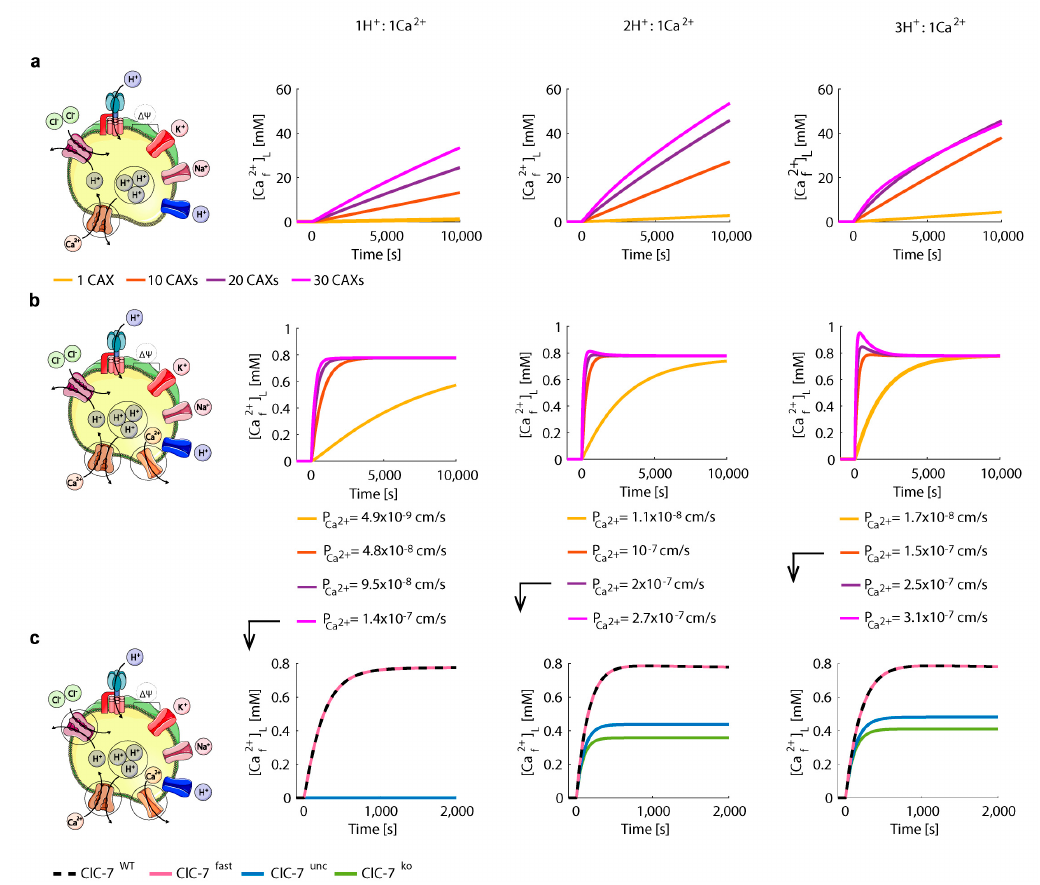
Figure 5. Ca 2+ /H + exchange mediates effective Ca 2+ uptake in the presence of a Ca 2+ leak. ( a , b